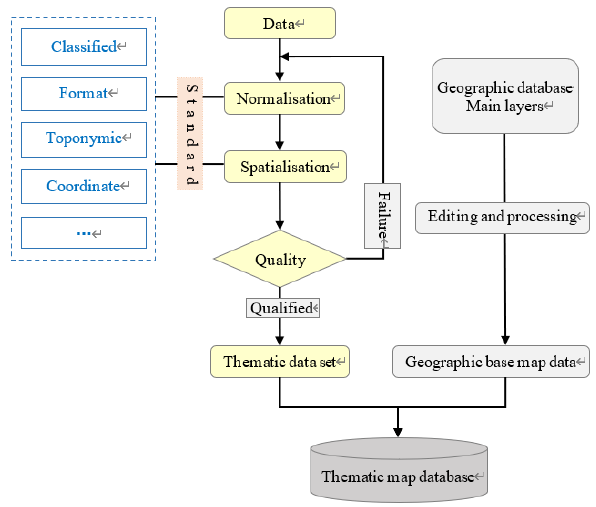
Figure 1 . Thematic map database building process. 1) Production of thematic geographic base map data: Based on the main element layers in the latest general geographic map database, national basic geographic map data with 1:9